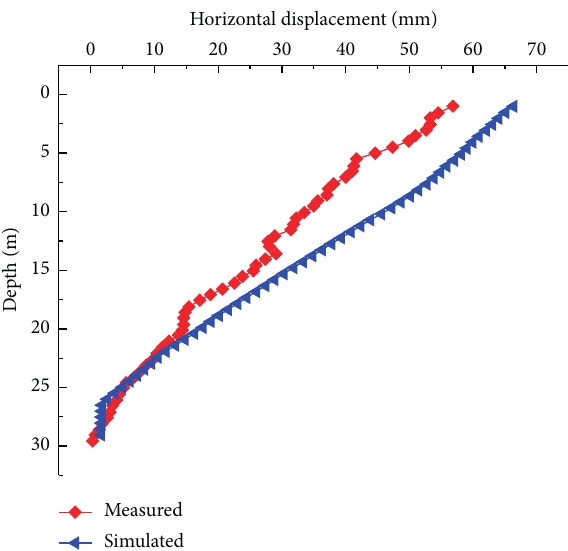
Figure 10: Comparison of measured and numerically predicted horizontal displacements.